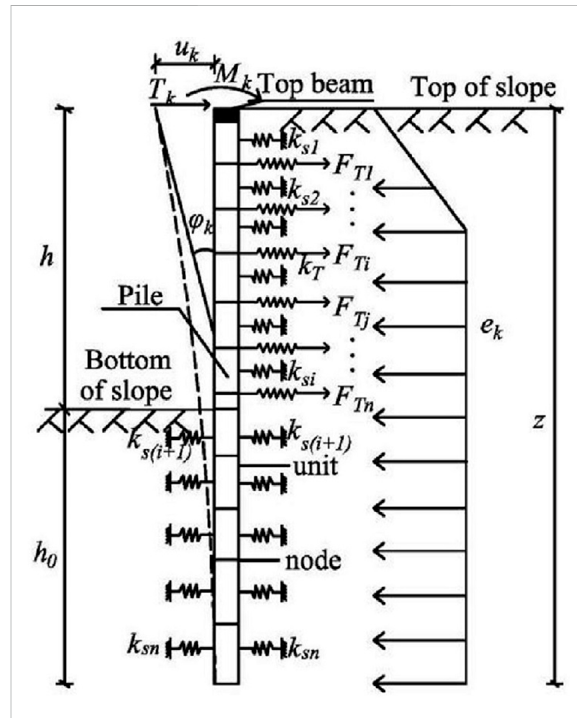
FIGURE 1 Calculation model of a single pile. Where h is the pile ’ s length above the ground, h 0 is the embedded section ’ s length, z is the supporting pile ’ s full length, k s is the equivalent stiffness of the soil spring, and k T is the anchor ’ s axial